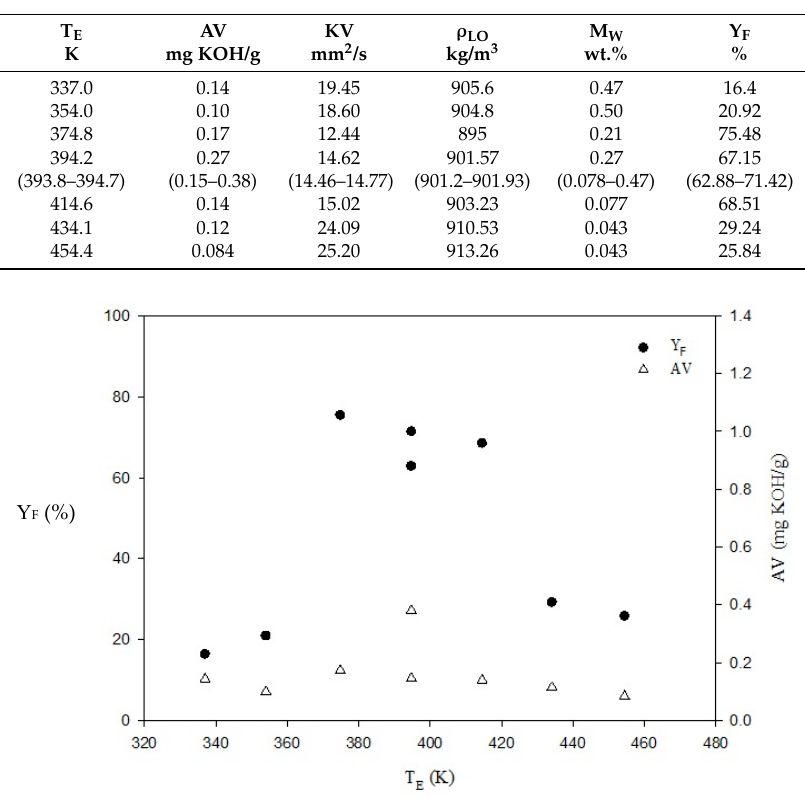
Figure 3. Effects of T E on Y F and AV for esterification of JO. M IOE = 5, M H/HO = 0.94 wt.%, Q IPA/H = 1.5 mL/min, t E = 58.5 min. P UI = 420 W.